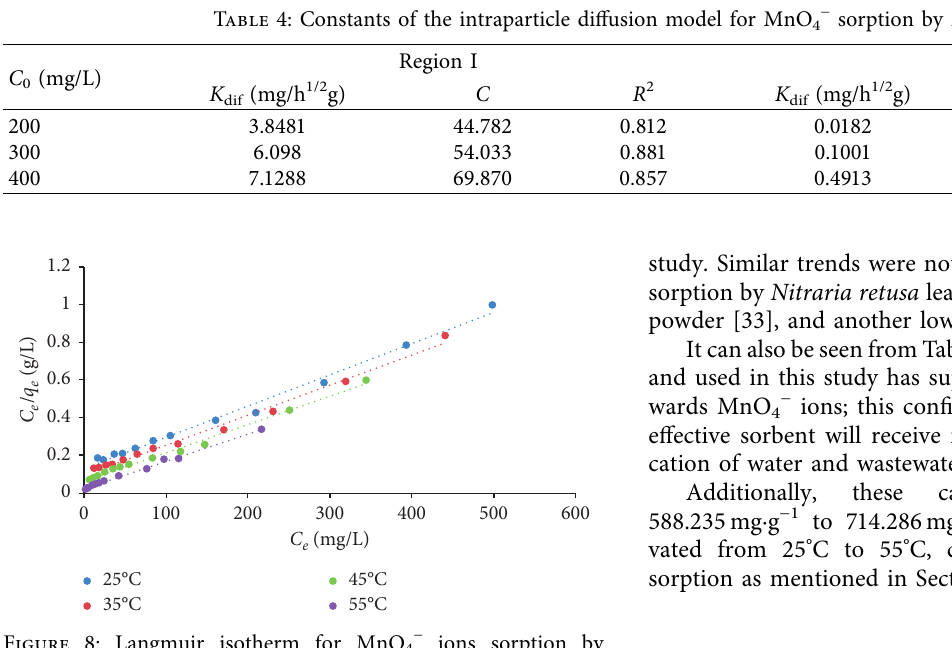
Figure 8: Langmuir isotherm for MnO ZCOBLP.